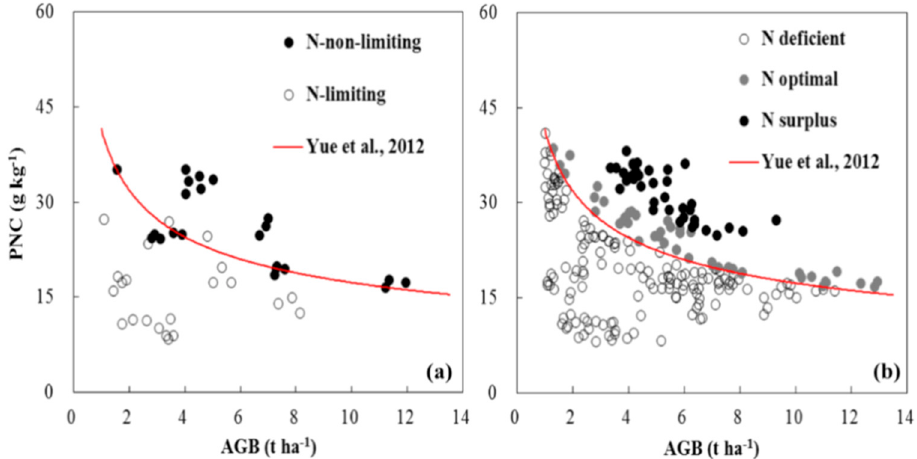
Figure 1. Evaluation of the existing critical nitrogen (N) dilution curve for winter wheat in